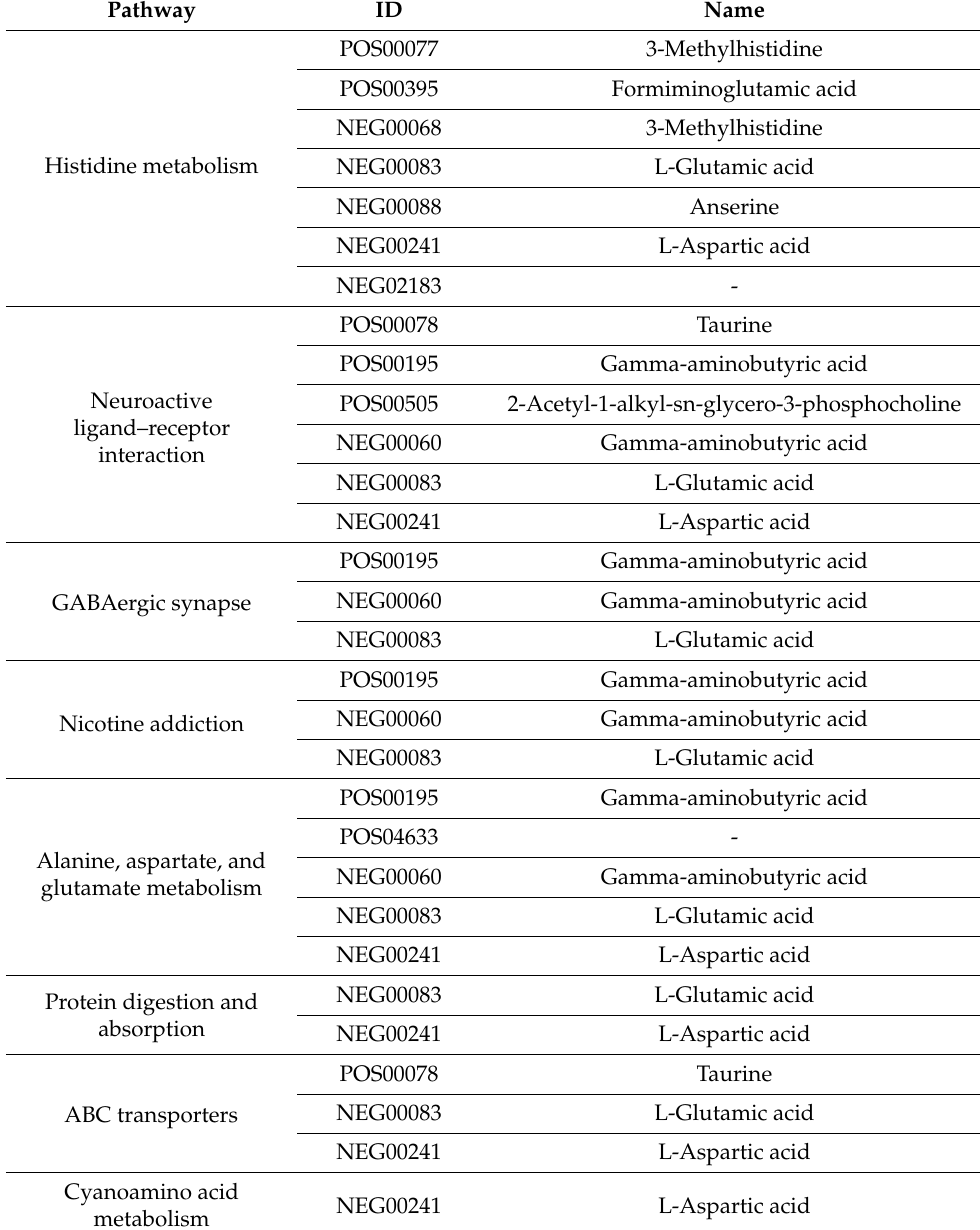
Table 1. Common pathways of the three groups and the taste metabolites involved in the pathways. Pathway ID